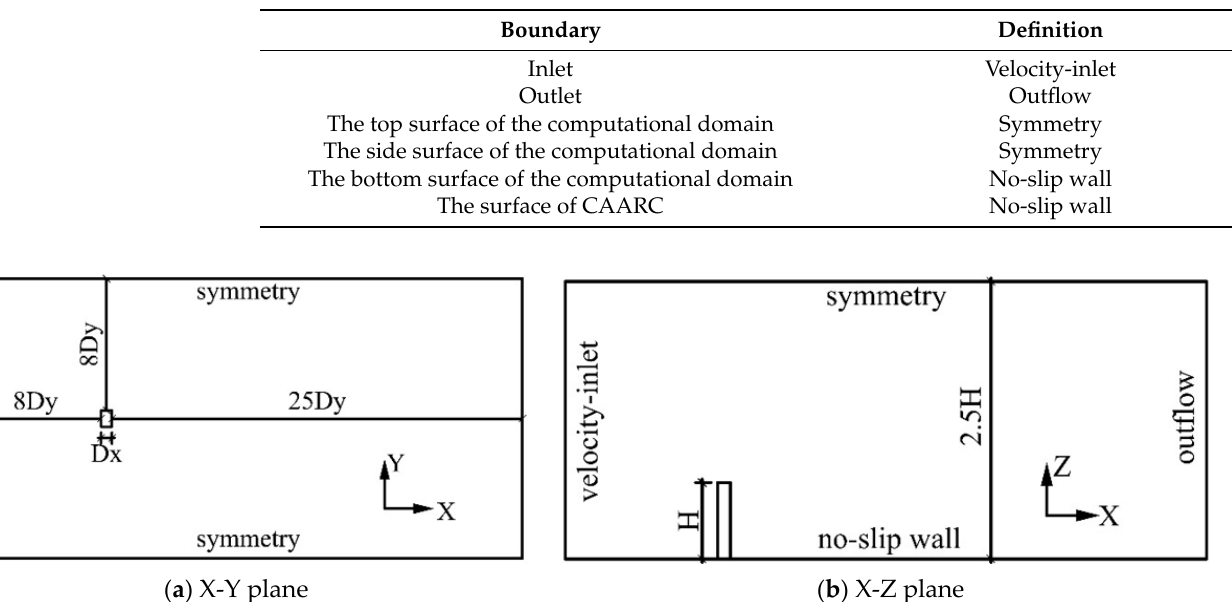
Figure 6. Dimensions and boundary conditions of the computational domain.